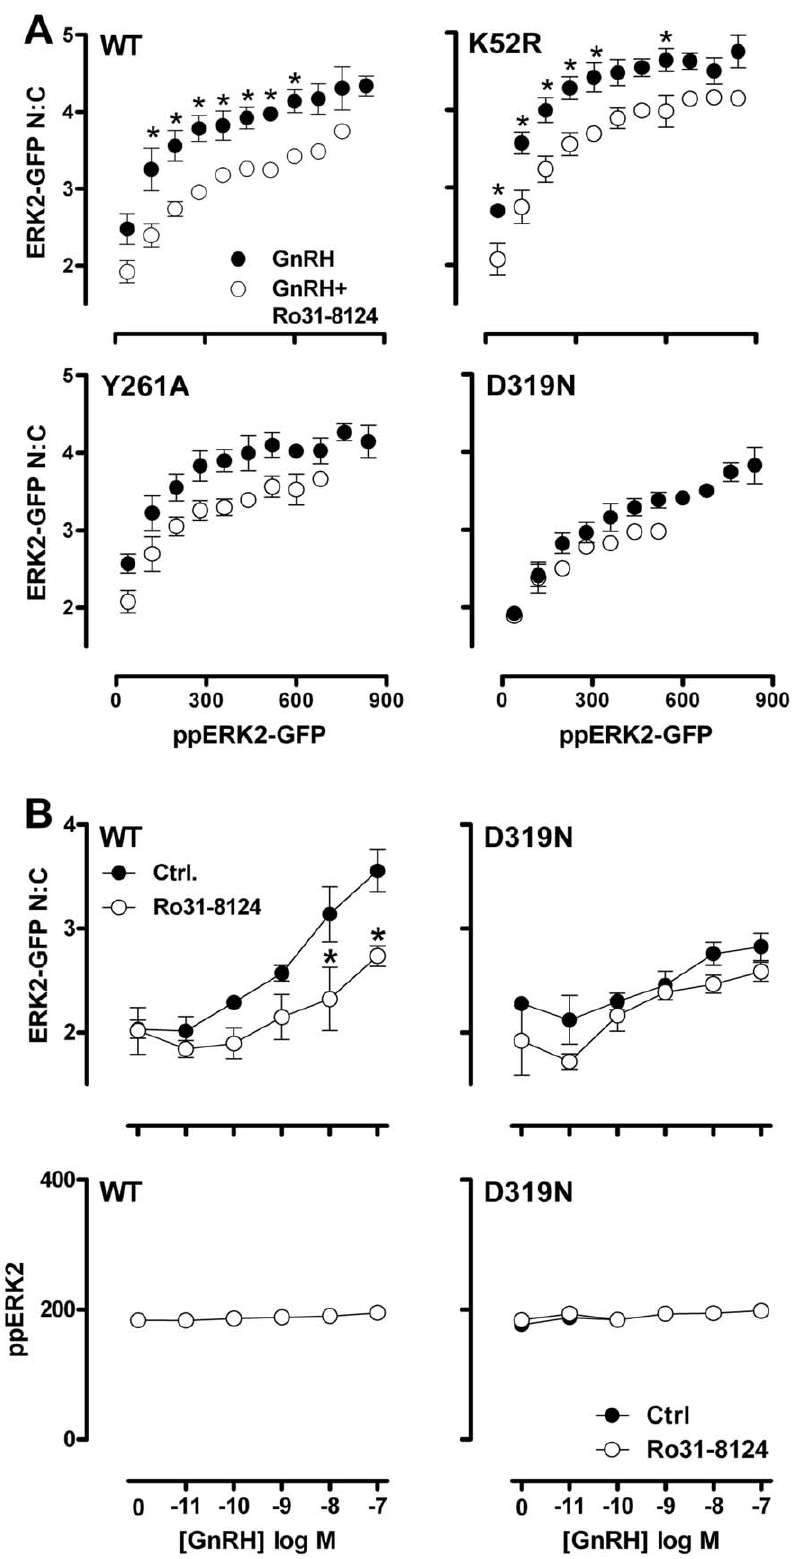
Figure 9. Effects of D319N mutation and PKC inhibition on TEY phosphorylation unattributable nuclear localization of ERK2-GFP are not additive. HeLa cells transfected with ERK siRNAs were transduced with Ad wild-type (WT) or D319N-mutated ERK2-GFP as indicated and incubated with vehicle (filled dots) or 200 nM Ro31-8425 PKC inhibitor (open dots) 10 minutes priors to stimulation with 100 nM GnRH for 5 minutes. Cells were then fixed, imaged and analysed as described in the Methods. The plots show comparison of average ERK2-GFP N:C ratio in cell